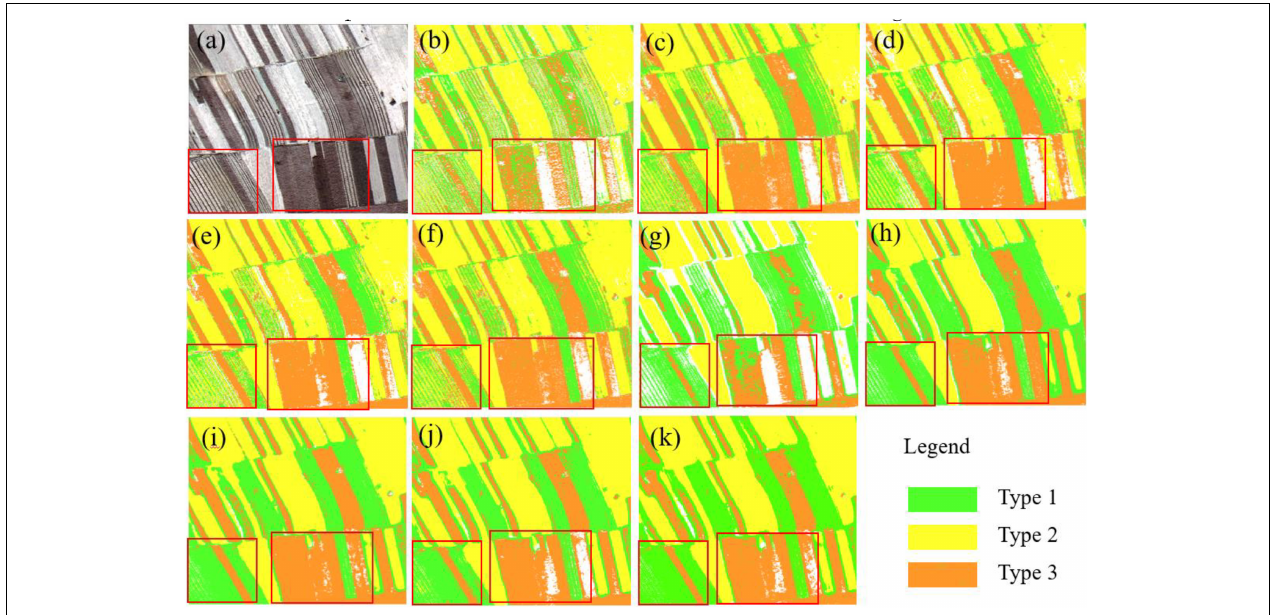
The bold values represent the model with the best performance.